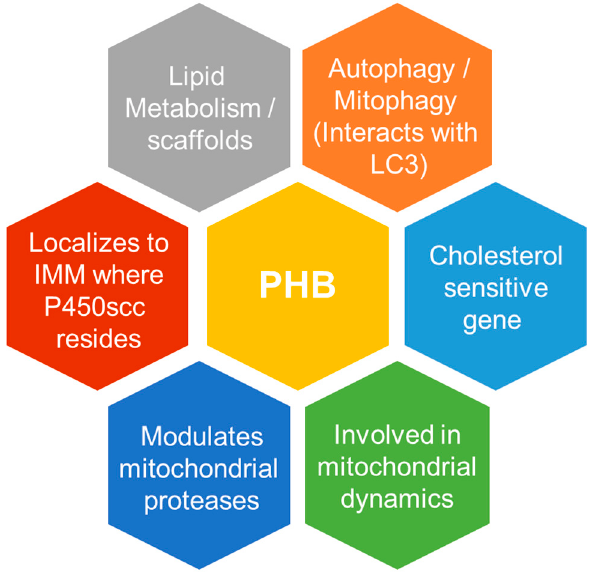
Figure 4. Schematic diagram depicting mitochondria, autophagy and lipid metabolism/scaffold-related known attributes of PHB that makes it an apt candidate in integrating the steroidogenic mitochondria with cholesterol mobilization and trafficking in steroidogenic cells.